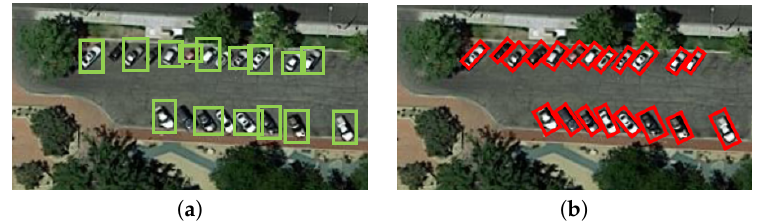
Figure 6. Detection results from the horizontal rectangle coordinates and the inclined bounding boxes: ( a ) With horizontal rectangle coordinates, densely packed objects can be missed because the IoU between two adjacent targets is too large. ( b ) With the inclined bounding boxes, the IoU from densely arranged objects can be well calculated and improves the recall